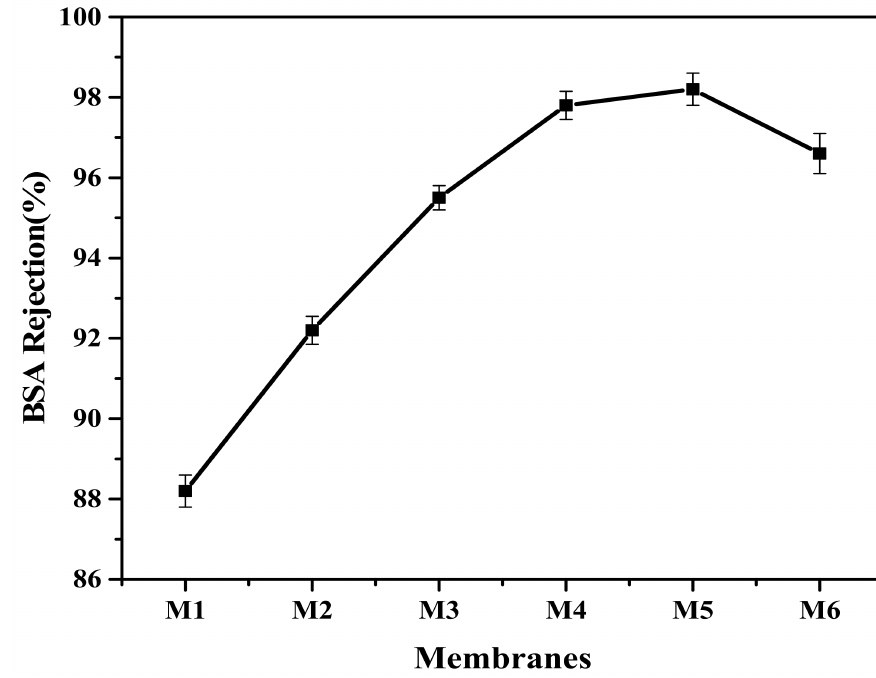
Figure 11. BSA rejection of aminated graphene oxide–based PVDF membranes. Methyl orange and methylene blue show maximum dye removal at 96.6% and 88.5%. For methyl orange at maximum concentration, rejection increases and then decreases by increasing the concentration of aminated graphene oxide. Similarly, methylene blue shows maximum rejection for M2 membrane, and thus on further increase of concentration of AGO, rejection decreases (Figure 12). Several coordinating functional groups present on GO surface facilitate the adsorption of dye during rejection. The interaction between positively charged nitrogen groups of methylene blue and methyl orange and the COOH and OH group of GO sheets facilitate the removal of dye molecules from water. Further- more, methylene blue showed an opposite trend that might be due to the coagulation of composite at high concentration and effective surface area is not sufficient for methylene blue degradation [50].